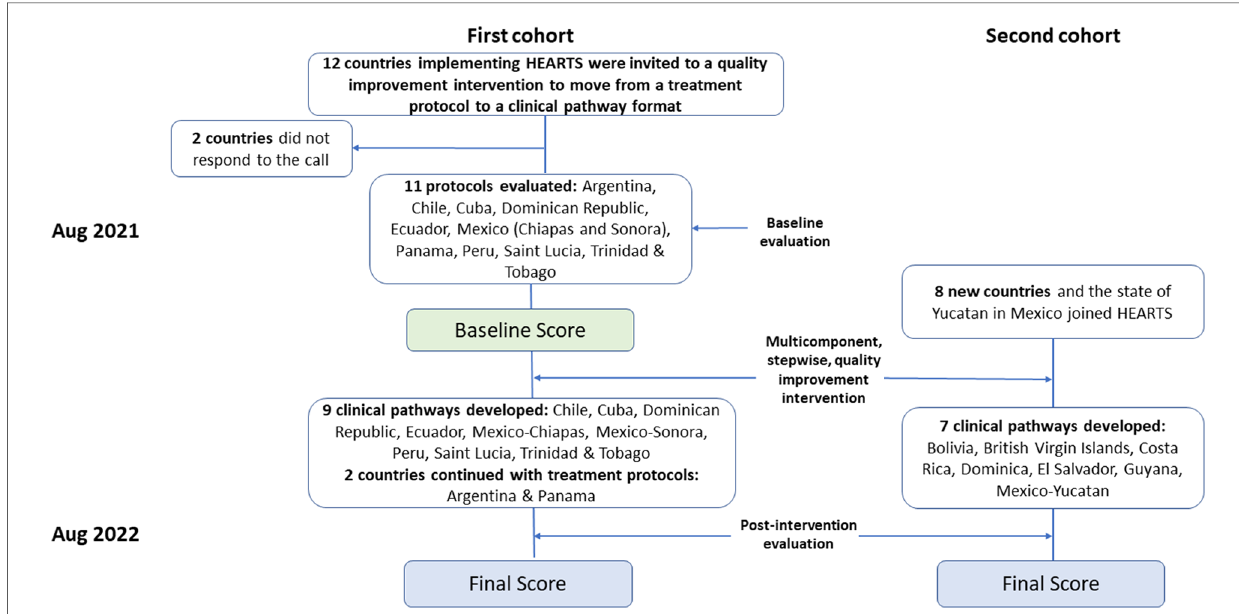
FIGURE 2 HEARTS in the americas. Intervention and evaluation process to move from a standardized hypertension treatment protocol to a CVD risk management clinical